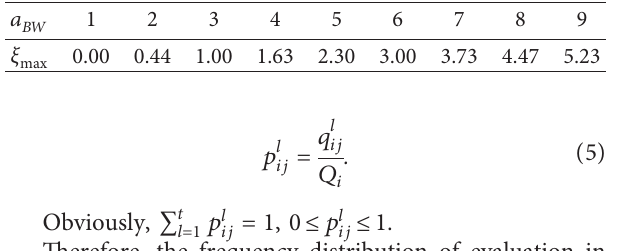
Table 3: Consistency